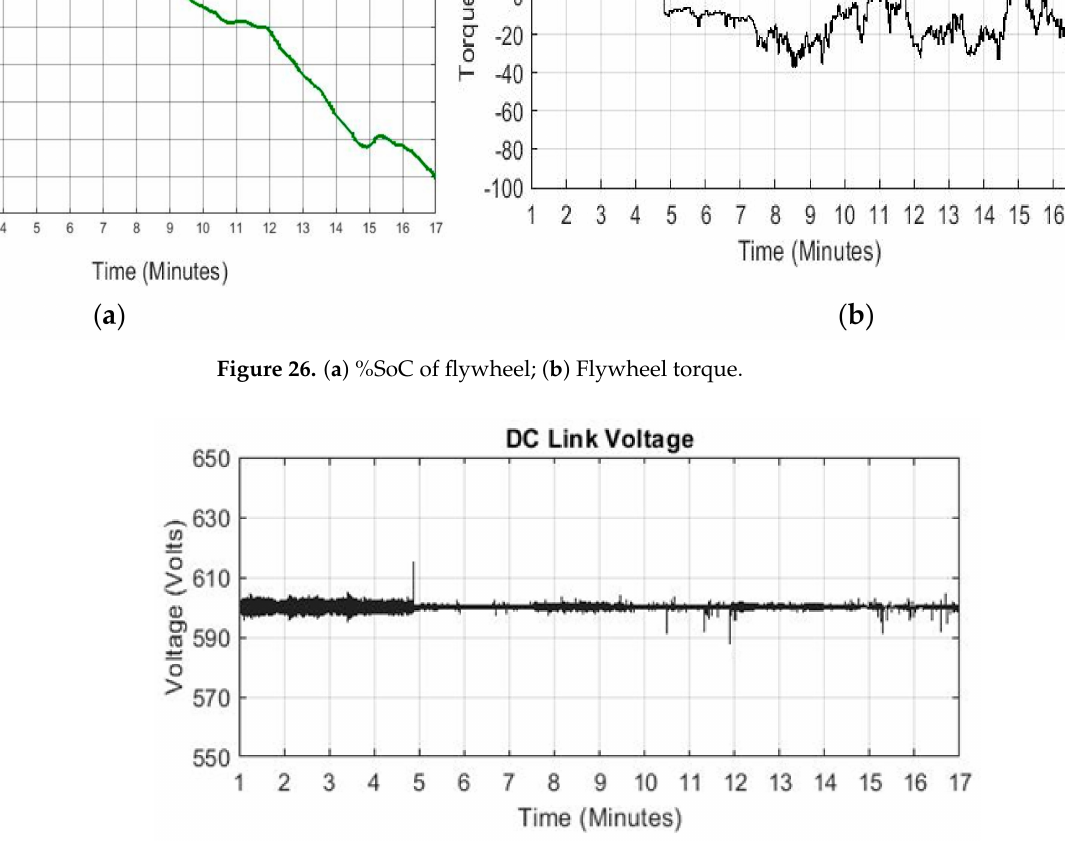
Figure 27. A DC link voltage for load profile 2 with flywheel